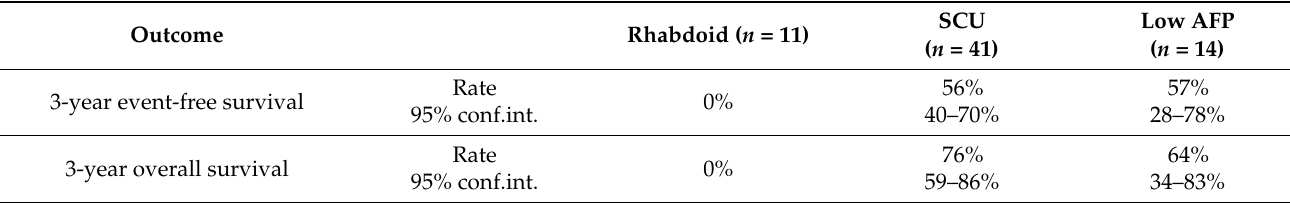
Table 3. Event-free survival and overall survival by group.